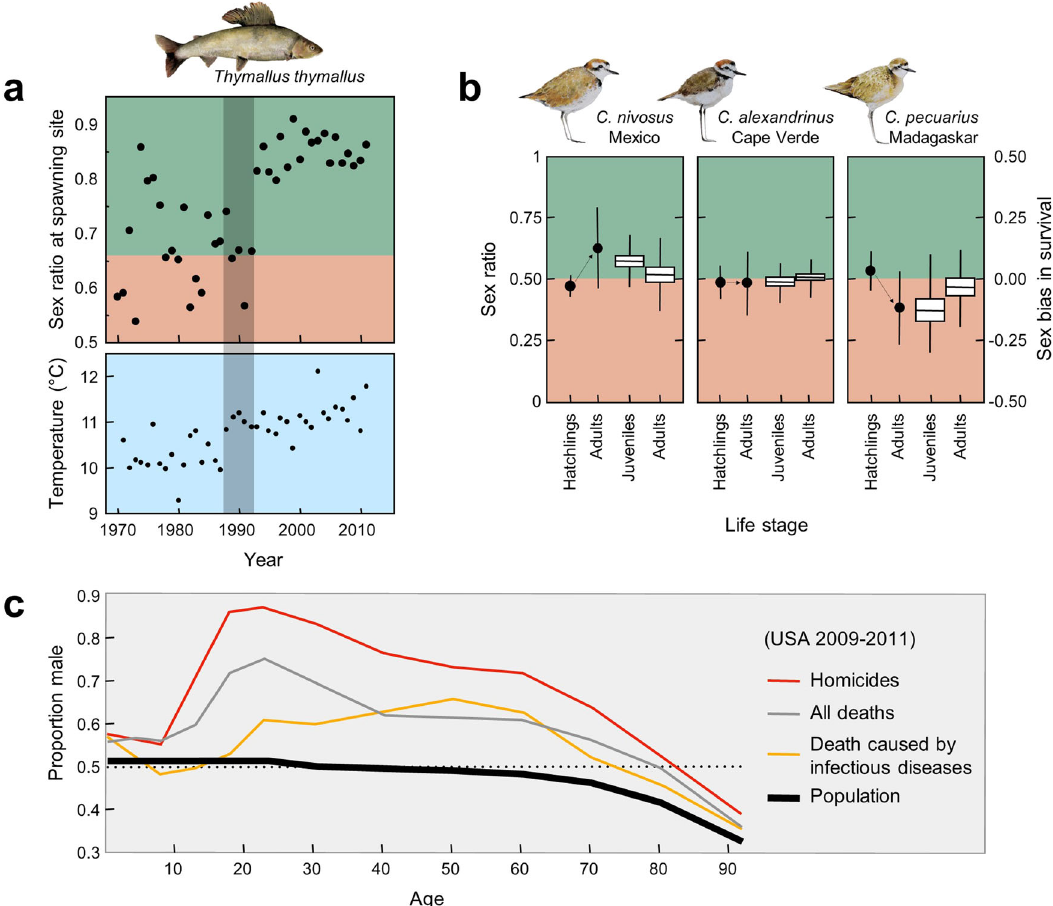
Fig. 2 Causes of ASR variation in grayling, shorebirds, and humans. a Adult sex ratios link to climate change in grayling of Lake Thun, Switzerland: male- biased adult sex ratios during spawning period 57 and average yearly water temperatures at the spawning site. The transition from the red to the green background indicates the average yearly adult sex ratio from 1948 to 1992. These adults were on average fi ve years old, and the gray shading highlights the 5-year period after the global temperature regime shift in 1987/88 168 . b ASR and demographic parameters in three plover species ( Charadrius spp ): hatchling and adult sex ratios (round symbols; means and 95% CI) and sex-speci fi c juvenile and adult survival (medians, quartiles, and ranges) 58 . c Sex ratios and proportions of death by sex across human age groups presented for homicides, infections/parasitic deaths, and all causes (US Census data 2009 – 2011). Drawings by Lara Wedekind using data from refs. 58,168